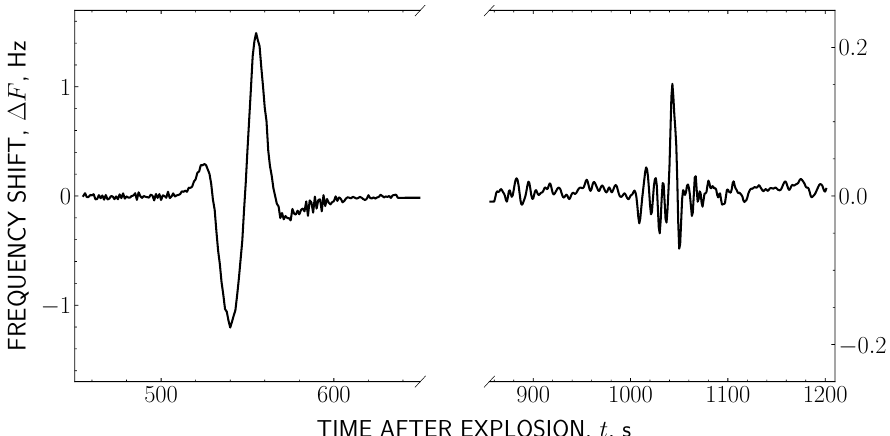
Figure 10. The effect of Doppler frequency shift detected by ionosphere sounding after an under- ground nuclear